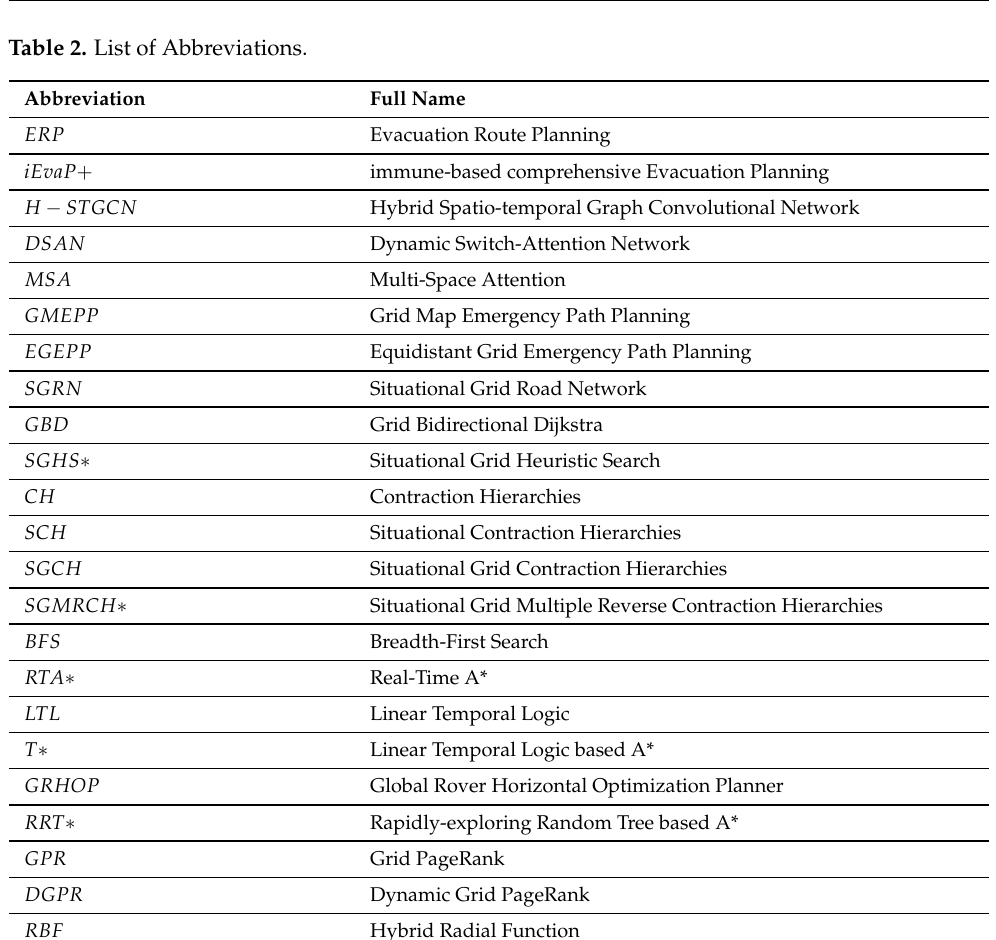
Table 2. List of